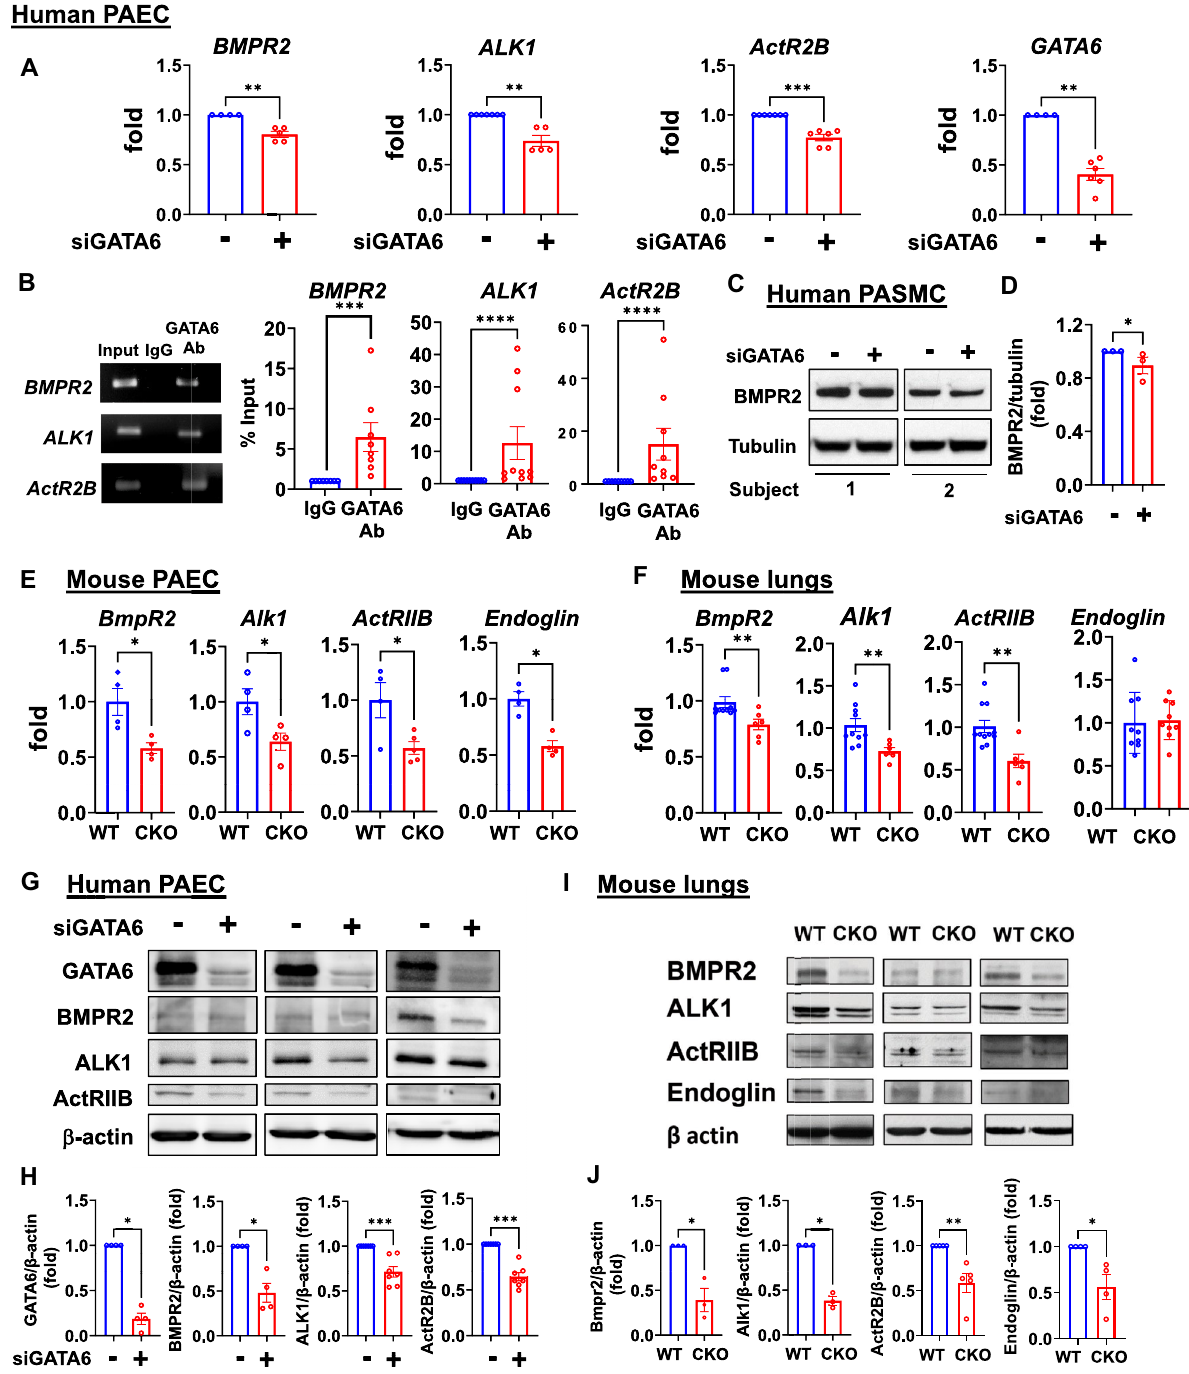
Figure 5. GATA6 deficiency in PAEC and PASMC results in loss of BMP receptors. ( A ) qPCR of HPAECs transfected with GATA6 or control scr siRNA ( − ) to measure indicated mRNA, each experiment was repeated at least three times. Data are means ± SE, n = 4–7. **p < 0.01, ***p < 0.001 by Mann Whitney U test. ( B ) Chromatin immune precipitation (ChiP) assay in HPAECs, n = 8–10. Representative gel images and data quantification are shown. Data are means ± SE, ***p < 0.001, ****p < 0.0001 by Mann Whitney U test. ( C,D ) Immunoblot analysis of control human PASMC transfected with siRNA GATA6 or control scr siRNA for 48 h. Data are means ± SE, 3 subjects/group, *p < 0.05 by Mann Whitney U test. Please see Fig. 2F,G for GATA6 immunoblots. ( E,F ) Expression of BmpR2, Alk1 , ActRIIB, and endoglin measured by qPCR in PAEC ( F ) and whole lungs ( G ) from WT and Gata6 CKO mice. Data are means ± SE; E: n = 4–5/group; F: n = 6–11 mice/group. Male and female mice responded similarly. *p < 0.05, **p < 0.01 by Mann Whitney U test (( E,F ) BmpR2, Alk1 , and ActRIIB ) and unpaired τ test (F Endoglin ). ( G,H ) Control HPAECs transfected with siGATA6 or control scr siRNA ( − ) were assayed by immunoblot analysis to detect indicated BMP receptors. Values are means ± SE of the relative protein levels by densitometry, n = 4–7.*p < 0.05, ***p < 0.001 by Mann Whitney U test. ( I,J ) Immunoblot analysis of whole lung tissue from Gata6 CKO and WT mice. Values are means ± SE of the relative protein levels by densitometry, n = 3–5/group. Male and female mice responded similarly. *p < 0.05, **p < 0.01 by Mann Whitney U test. The original blots are presented in Supplementary Fig.